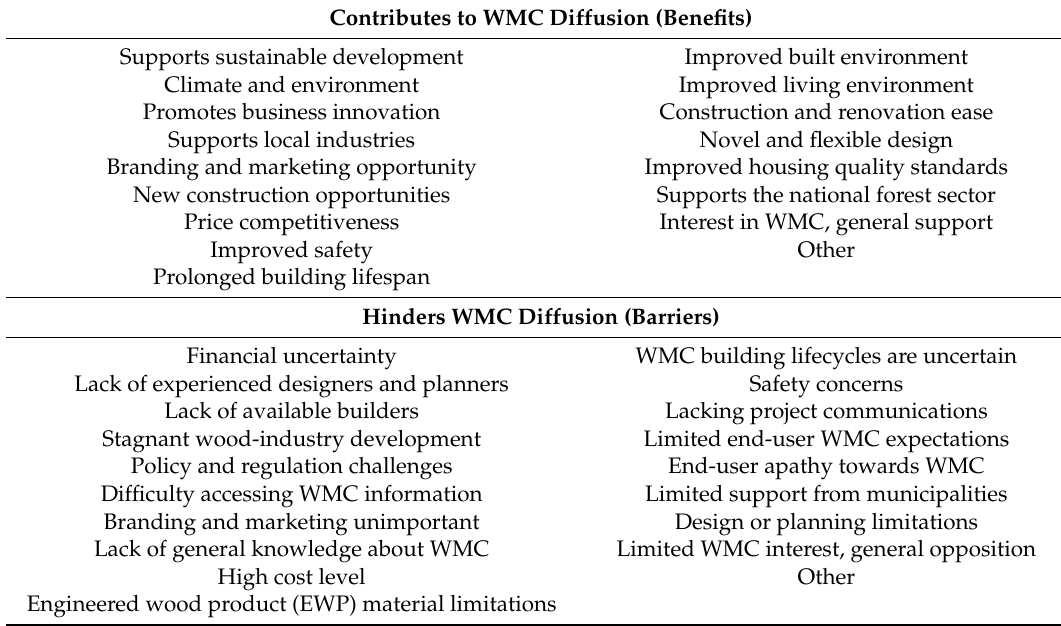
Table 4. Qualitative content analysis (QCA) thematic coding framework results for the main category